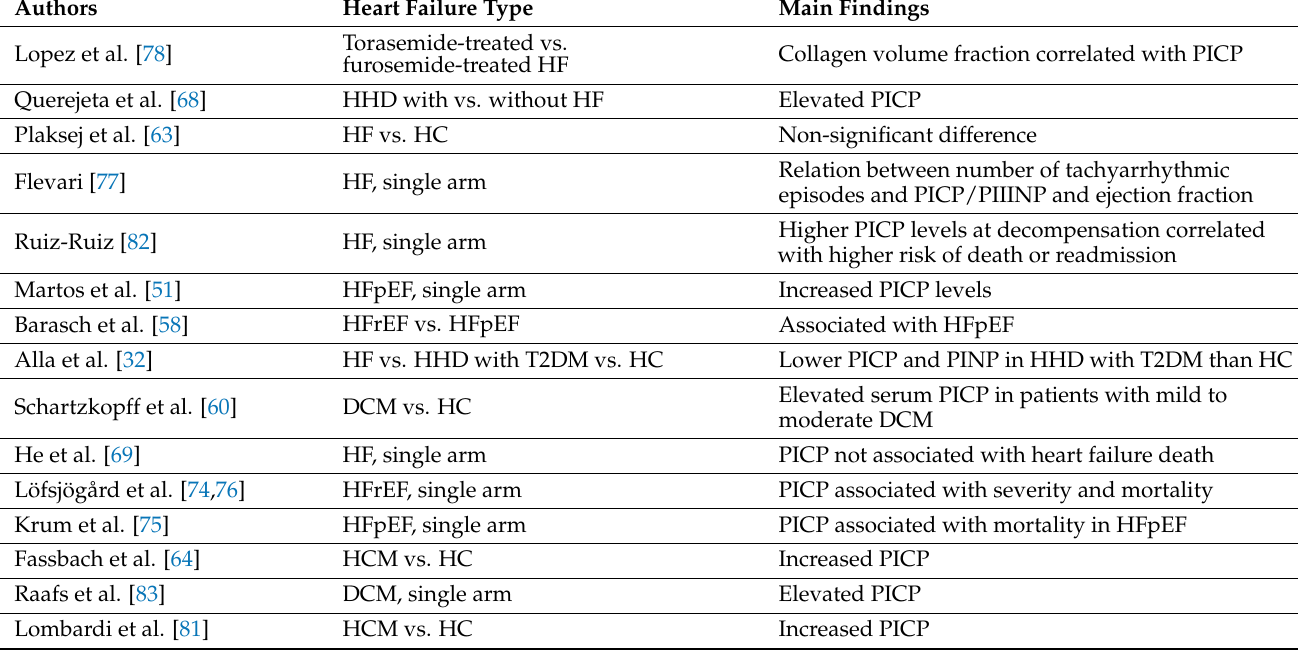
Table 2. Serum PICP concentrations in subjects with heart